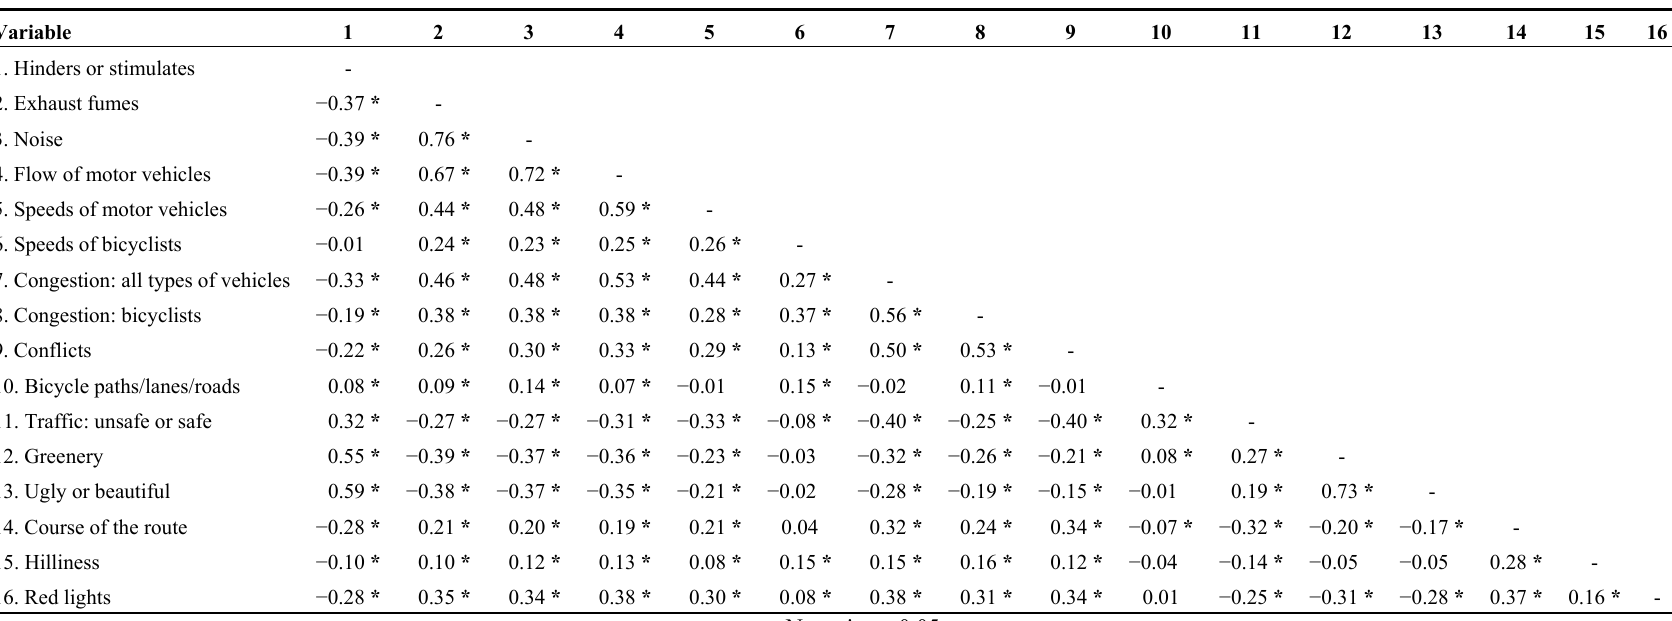
Table 4. Correlations between ratings of environmental variables (n =